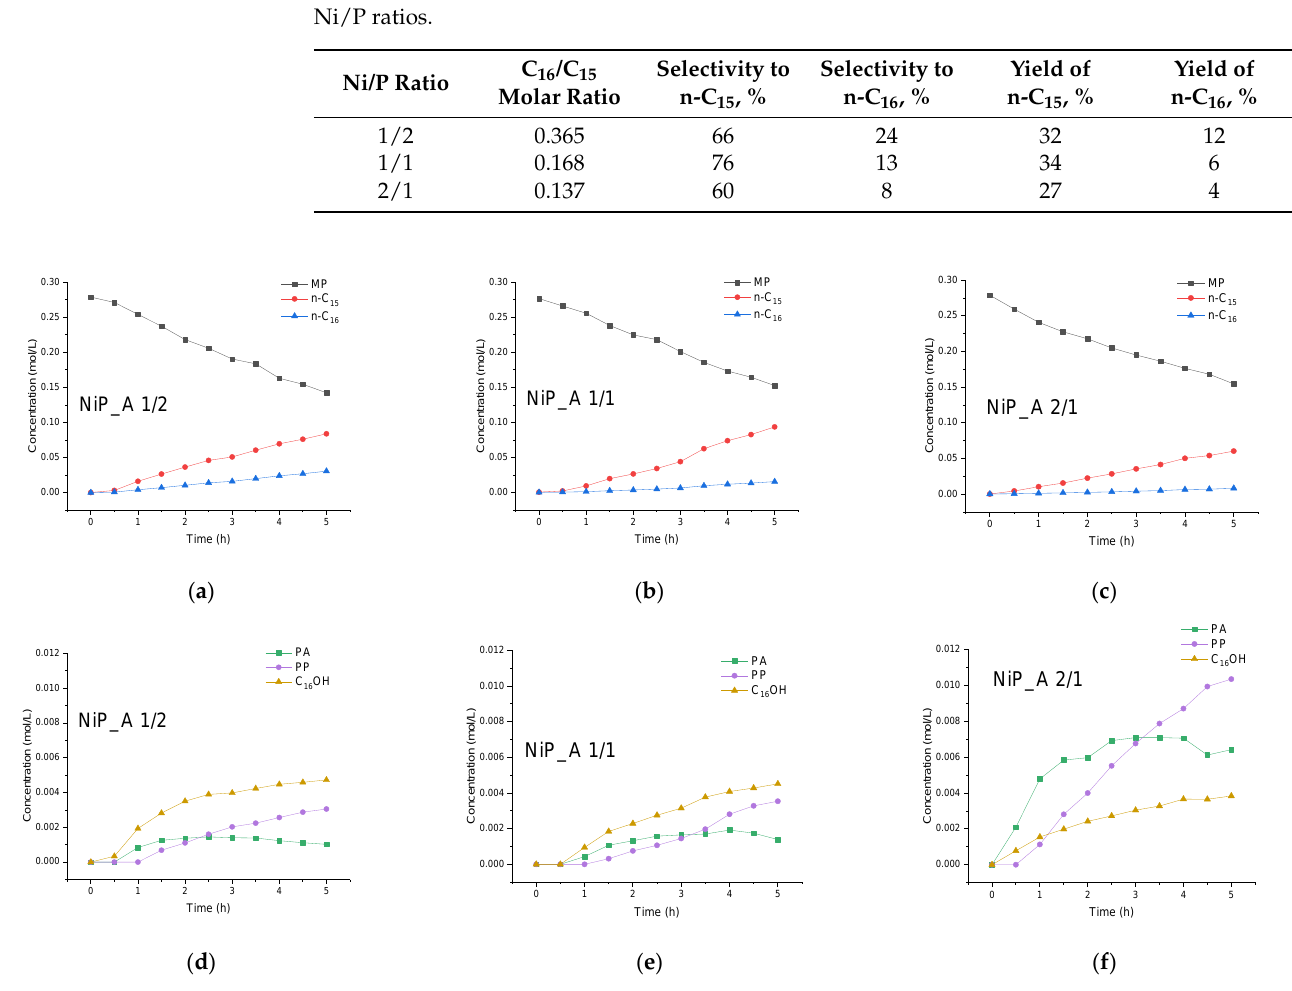
Figure 4. Concentration of reaction products vs. time in an autoclave over 7 wt.% NiP_A catalysts: ( a , d ) Ni/P = 1/2; ( b , e ) Ni/P = 1/1; ( c , f ) Ni/P = 2/1. MP, methyl palmitate; PA, palmitic acid; C 16 OH, hexadecanol. 290 °C, 3 MPa, V H2 = 100 mL/min, 500 RPM, m cat = 1 g.